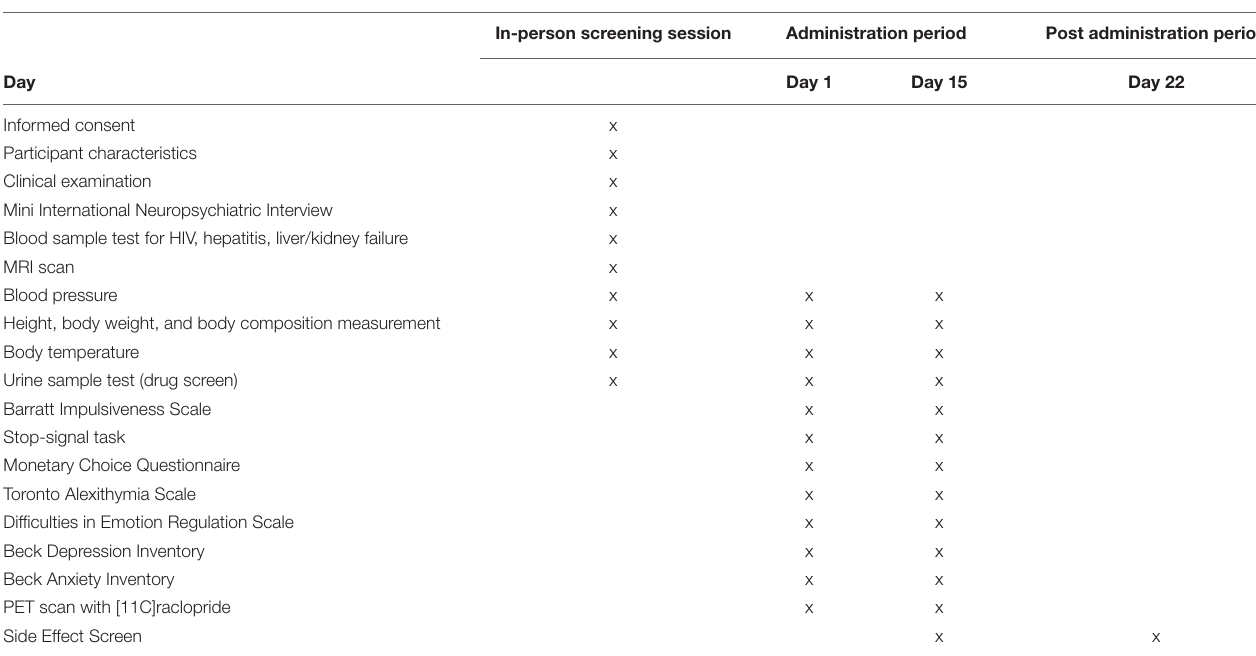
In-person screening